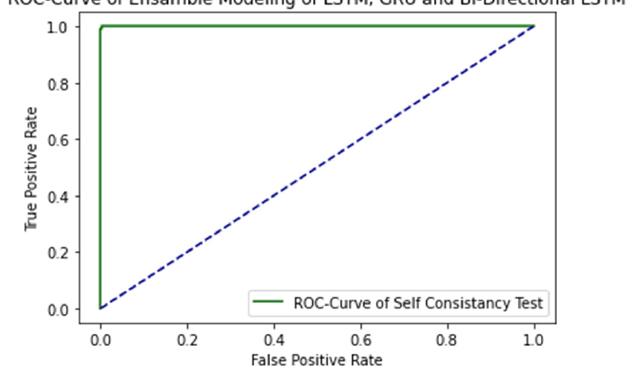
Figure 5. ROC Curve of proposed ensemble learning model with independent set test.